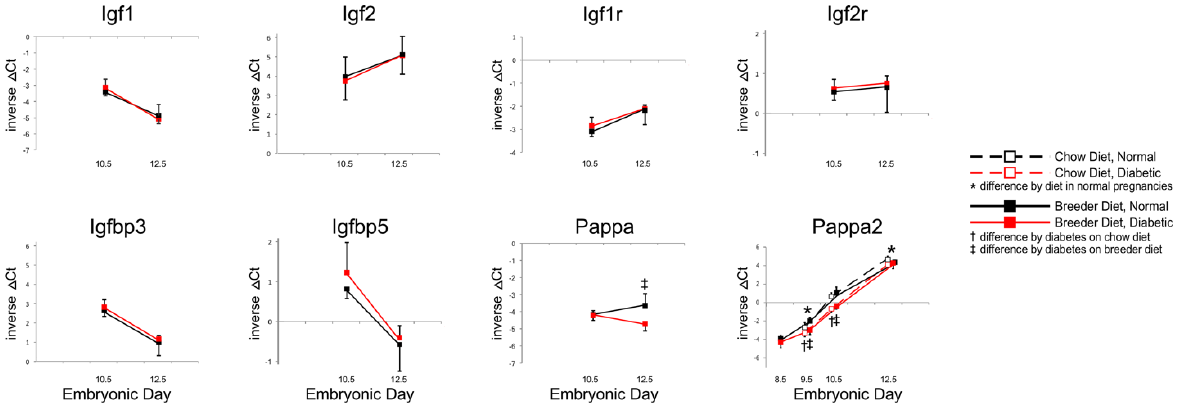
Figure 2. Expression of Igfs, their receptors, Igf-binding proteins and their proteases. Quantitative PCR measurements were performed at various time points, in dams that were either fed chow or breeder diet, and became diabetic in the week before, or were normoglycemic at the time of mating.